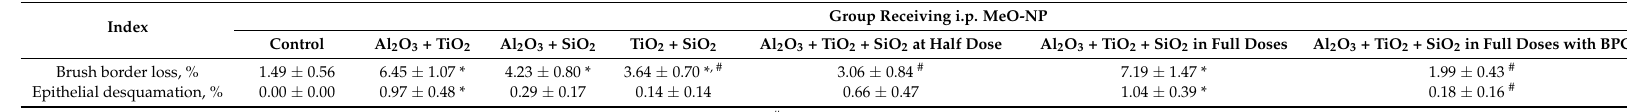
Table 5. Morphometric Indices of Damage to the Epithelium of the Proximal Convoluted Tubules in Rat Kidneys after Subchronic Exposure to Al 2 O 3 -NP, TiO 2 -NP and SiO 2 -NP in Binary or Ternary Combinations (x ±